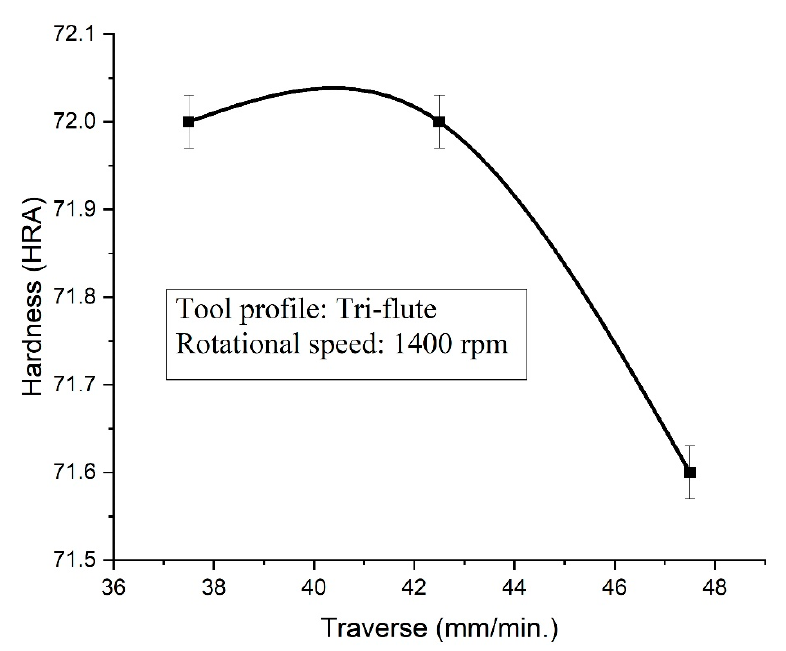
Figure 15. Influence of traverse speed on hardness strength.